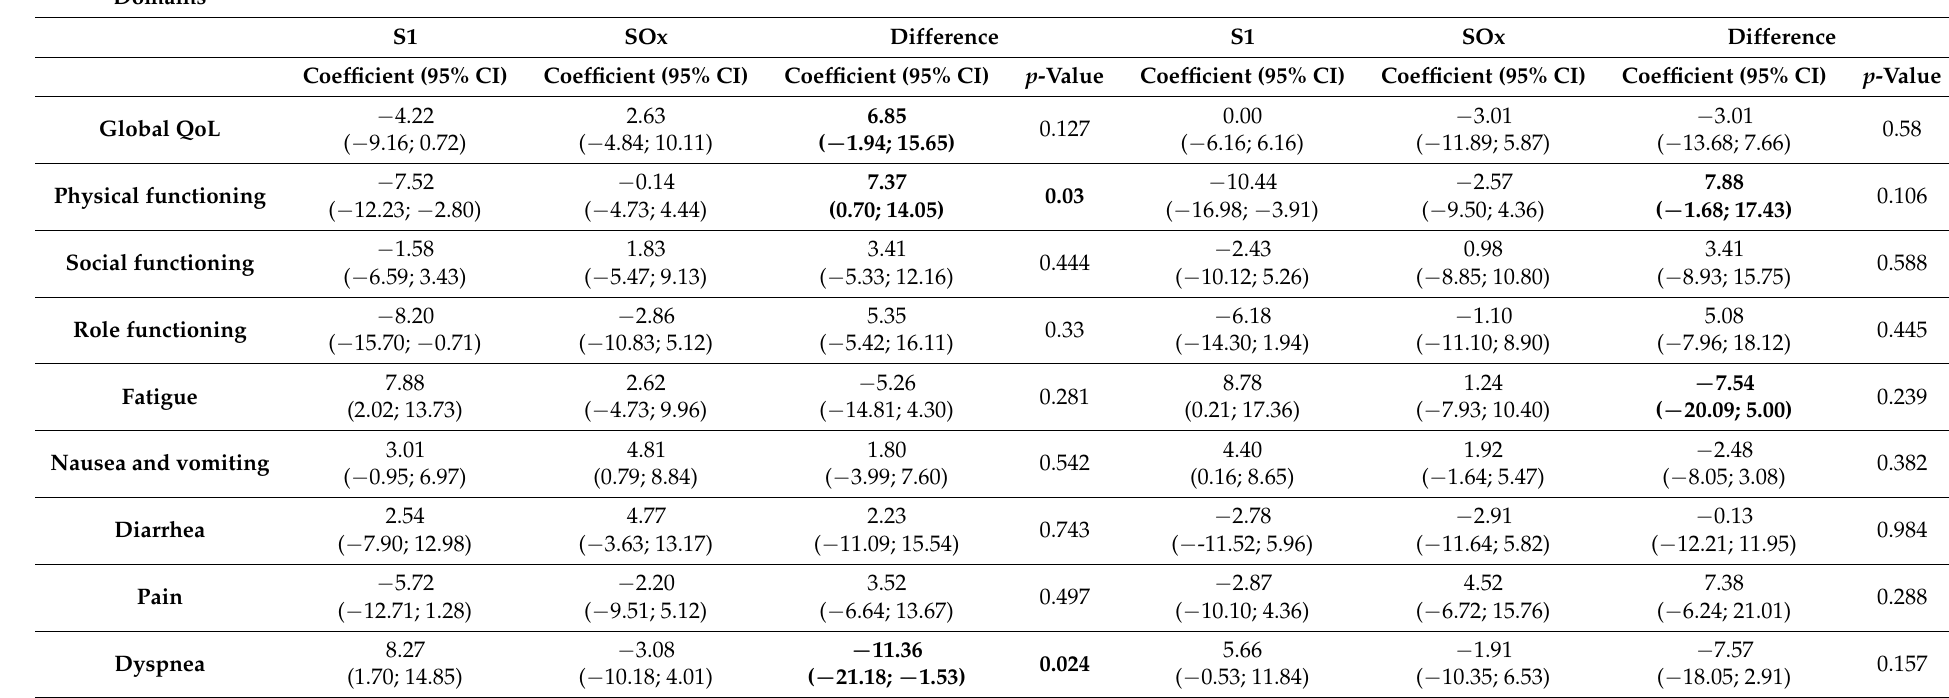
Table 3. Mean change coefficients and between-group differences with 95% confidence intervals of the EORTC QLQ-C3 domains from baseline to 9-week and 18-week follow-ups in the two treatment arms. Anchor based clinically relevant minimally important differences (MID) in patients with colorectal cancer receiving chemotherapy according to Musoro et al. are